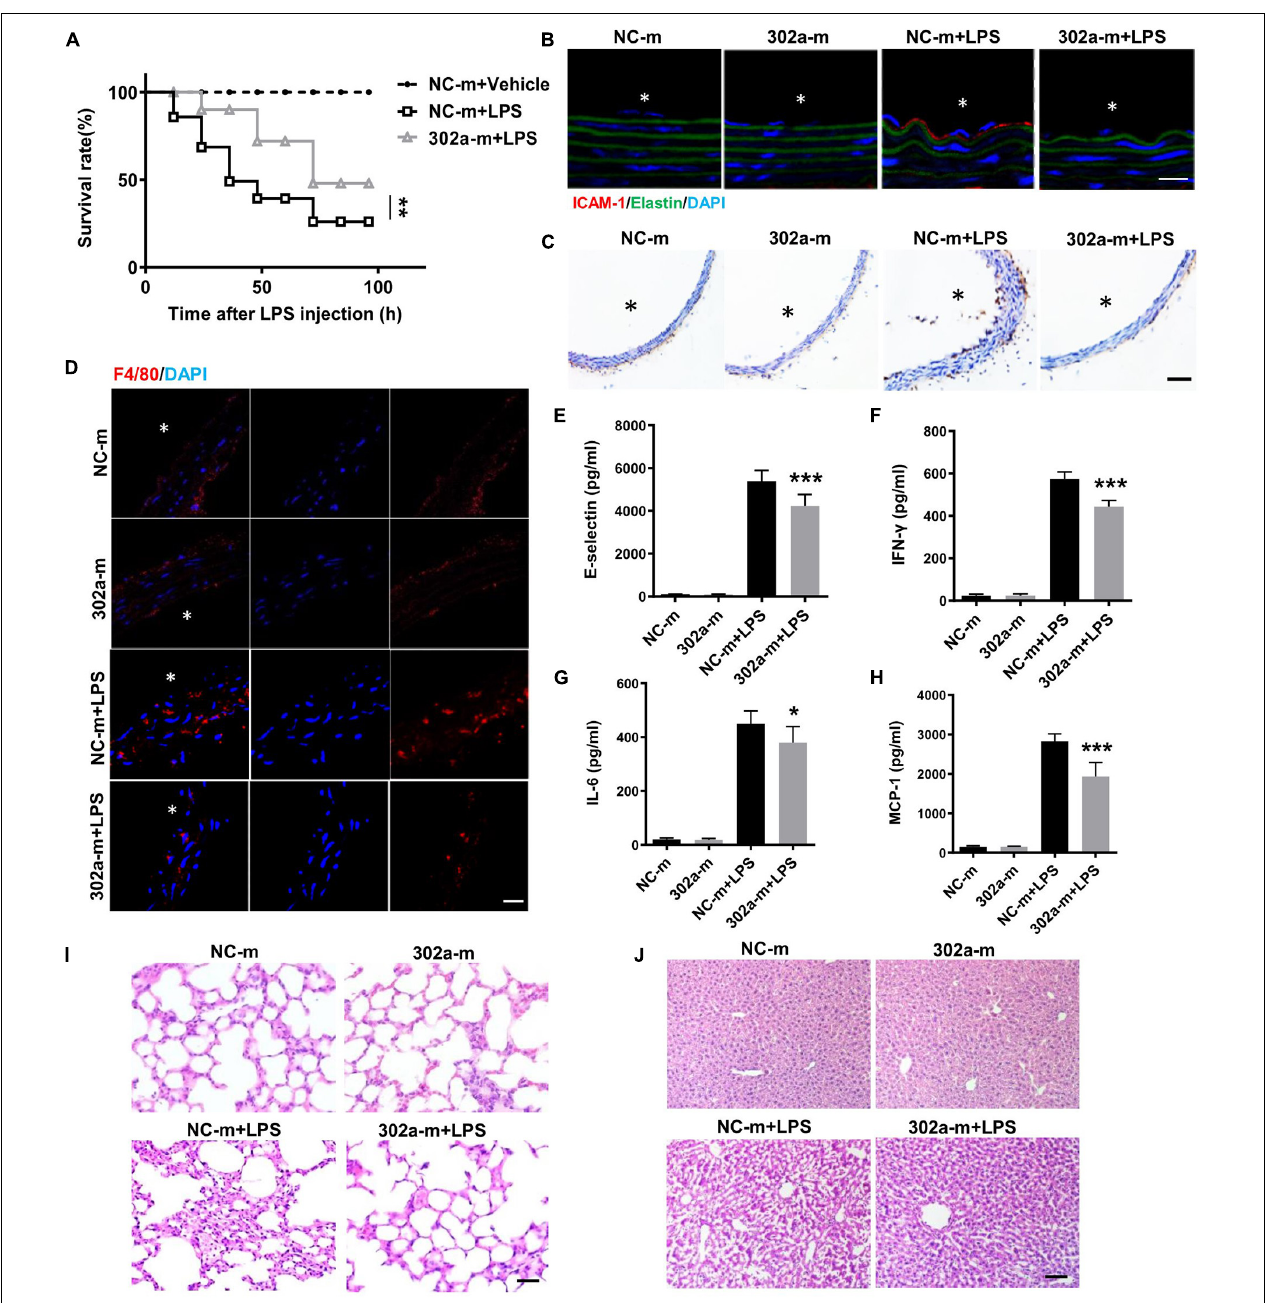
FIGURE 3 | MiR-302a-mimics weakens LPS-induced inflammation of mice. (A) The survival rate of 8 weeks’ WT mice injected with miR-302a mimics (302a-m) or negative control mimics (NC-m). WT mice were injected with LPS (25 mg/kg), n = 20. (B) Immunofluorescence of ICAM-1 in aorta from mice injected with miR-302a mimics or negative control mimics. n = 6, scale bar, 10 µ m, asterisk indicated the lumen of aorta. (C) Immunohistochemical staining of VCAM-1 of aorta from mice injected with mimics. n = 5, scale bar, 100 µ m. (D) Immunofluorescence staining of F4/80 represents the infiltration of macrophages (red) in the aorta, nuclei were counterstained with DAPI (blue), n = 6, scale bar, 50 µ m. The inflammatory factors of E-selectin (E) , IFN- γ (F) , IL-6 (G) , and MCP-1 (H) in serum of mice ( n = 6). The inflammatory status in lung (I) and liver (J) stained by HE, n = 6, scale bar, 100 µ m (* p < 0.05; ** p < 0.01; *** p < 0.001 vs. NC-m + LPS).